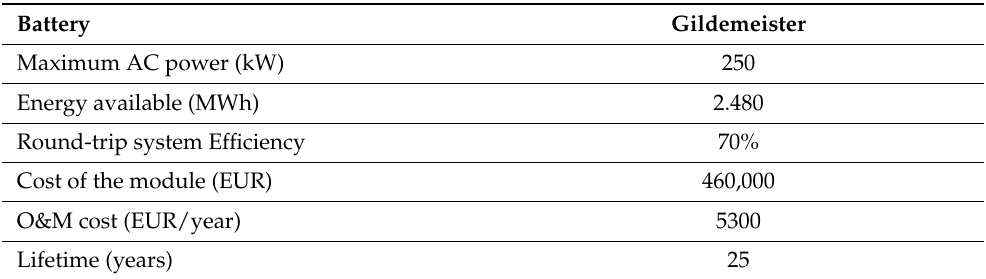
Table 6. Standard system specifications of the selected battery system